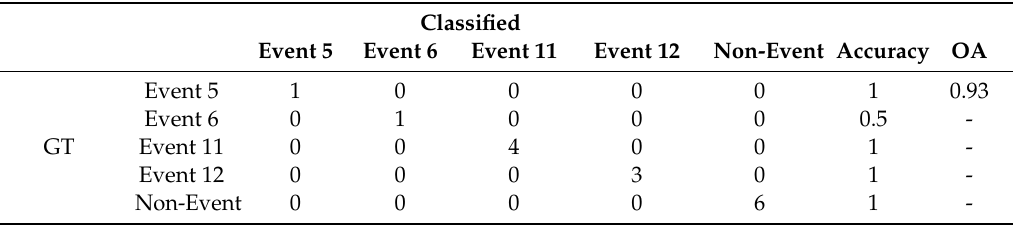
Table 12. Event classification using the rule-based approach for one VIRAT video: VIRAT_S_000102. The confusion matrix and OA are included.